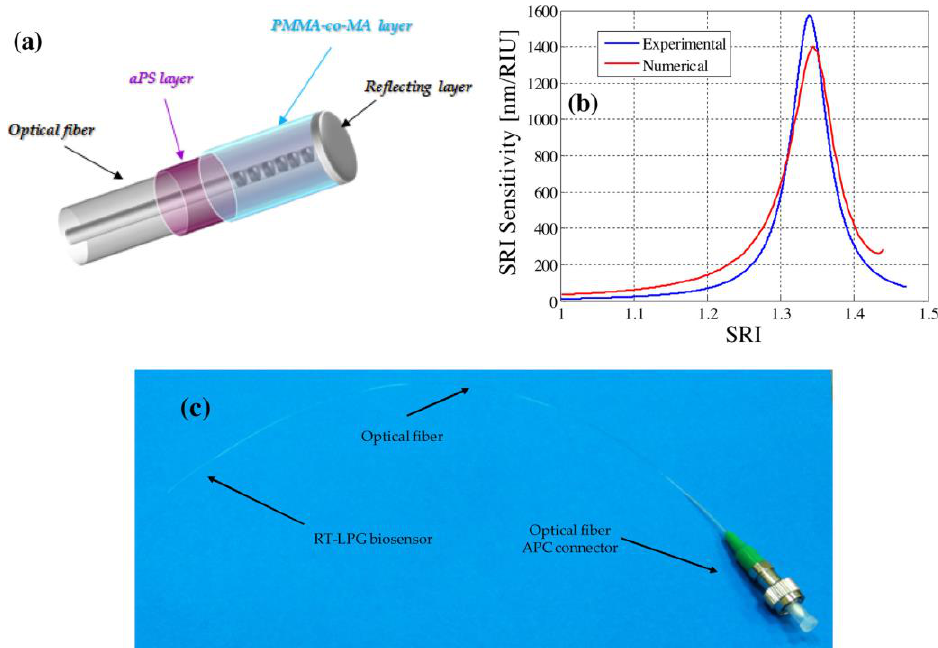
Figure 14. ( a ) Schematic view of the final reflective LPFG transducer; ( b ) the experimental and numerical SRI sensitivity; ( c ) a photograph showing the reflective LPFG biosensor probe developed in this work. Reprinted with permission from [123]. Copyright © 2016 Elsevier B.V.